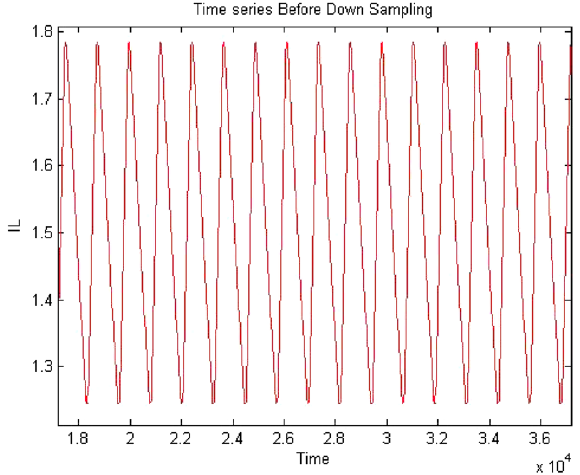
Figure 32. Time series of forward converter at period-1 before down sampling.